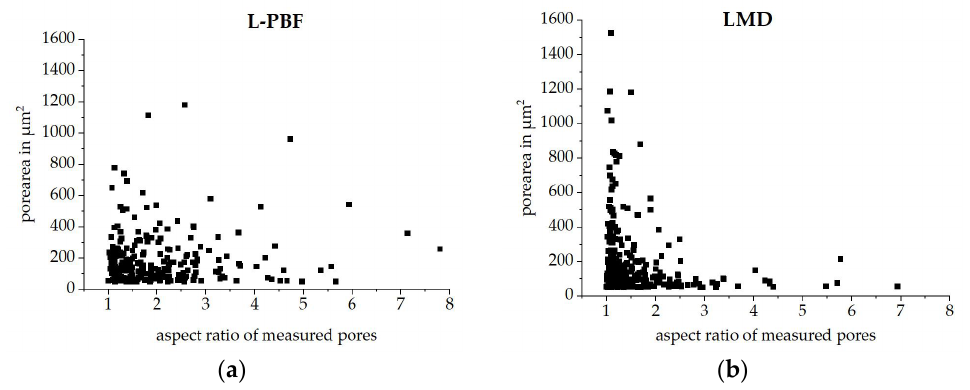
Figure 7. Correlation between aspect ratio and size of measured pores; ( a ) L-PBF samples; ( b ) LMD samples.